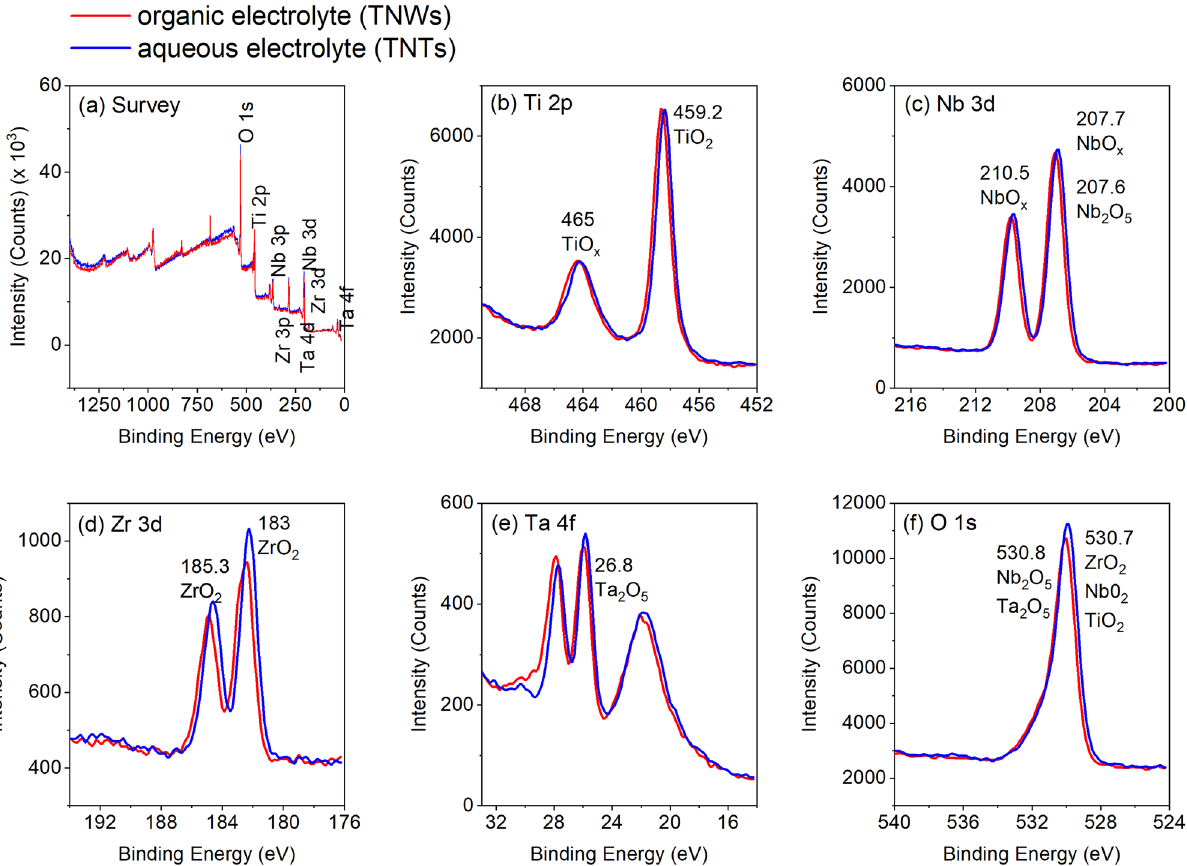
Figure 4. XPS analyses for the TNTs (anodization in the aqueous electrolyte) (blue line) and TNWs (anodization in the organic electrolyte) (red line). ( a ) Full survey spectrum and high-resolution spectra of ( b ) Ti